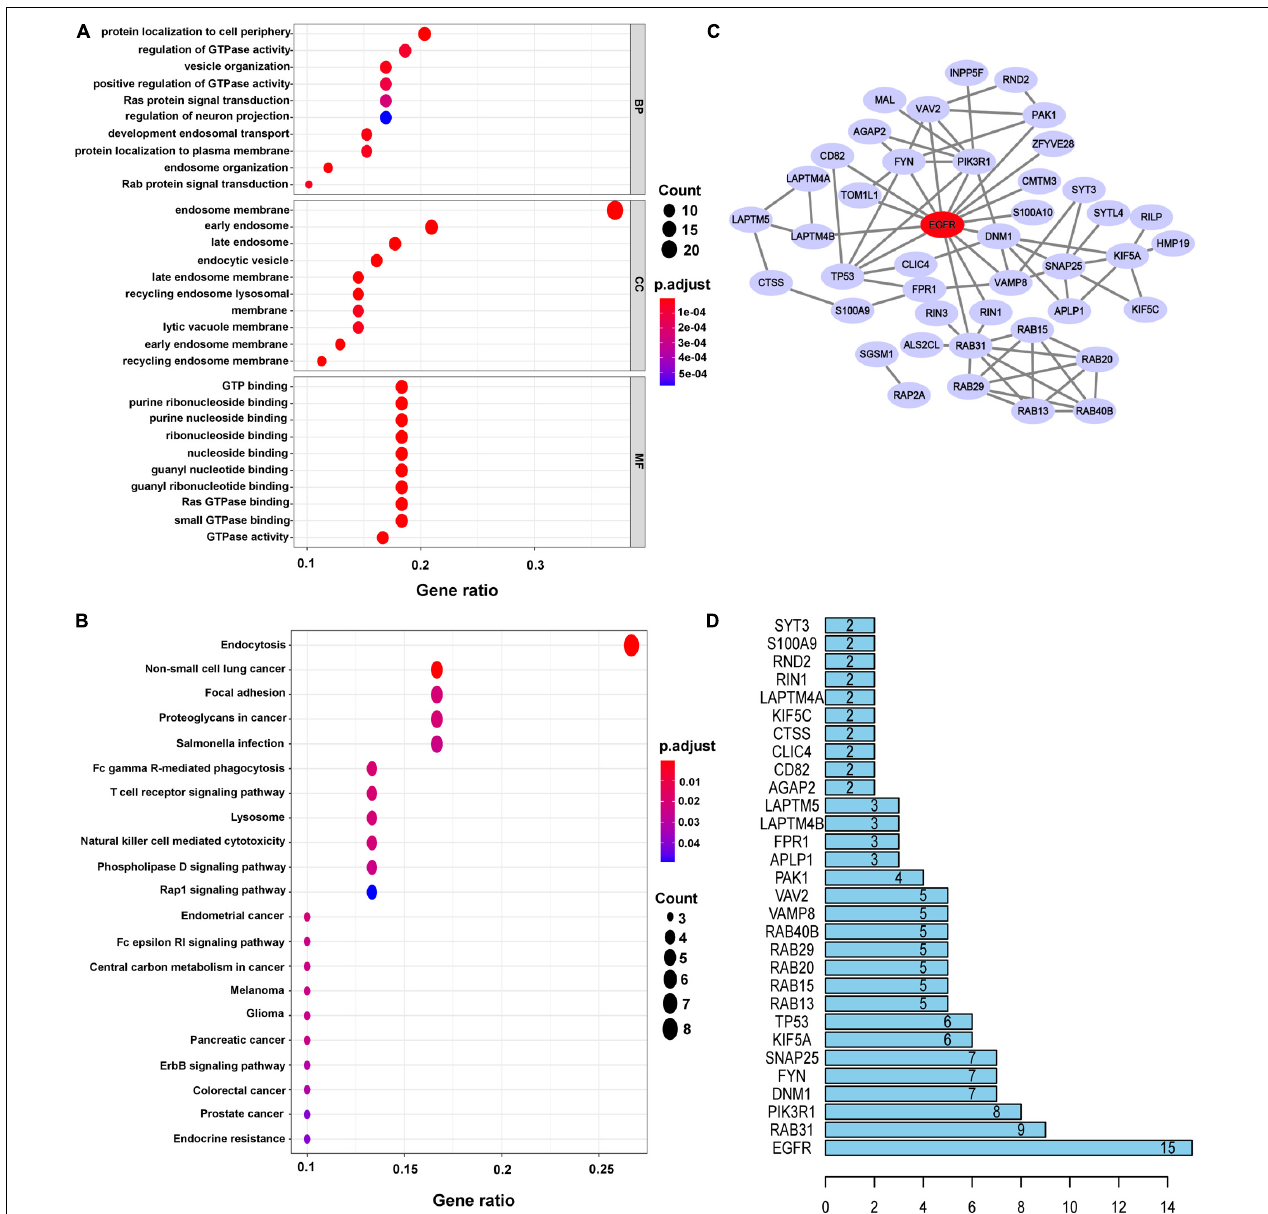
FIGURE 2 | Functional enrichment analysis and construction PPI networks of DEERGs. (A) GO analysis of DEERGs. (B) KEGG analysis of DEERGs. (C) Cytoscape constructed PPI networks of DEERGs. (D) Identification of EGFR as the central protein.